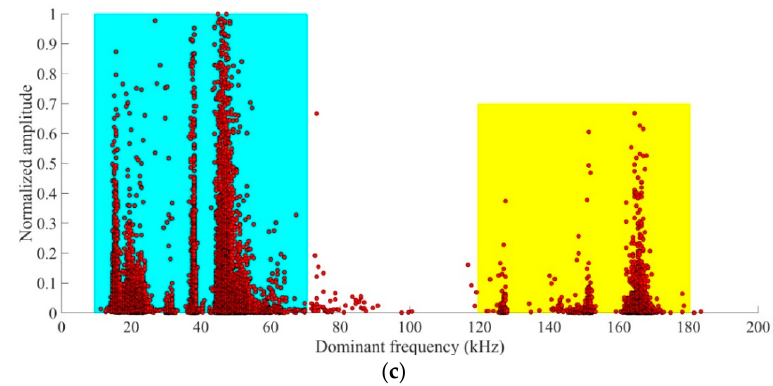
Figure 6. Normalized main frequency amplitude and count rate of specimens. ( a ) X-1 specimen; ( b ) X-3 specimen; and ( c ) X-6 specimen.